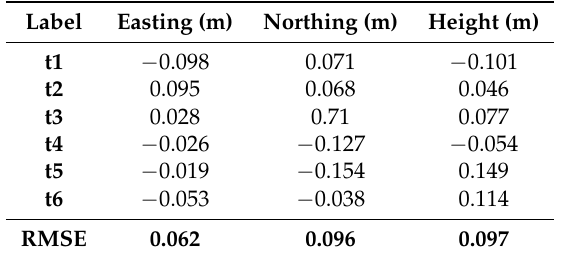
Figure 6. Ground Control Points’ (GCPs) distribution for the surveys on the tomato site. Map data: c (cid:13) Google Satellite. Table 3. Tomato site: residuals on the GCPs after bundle block